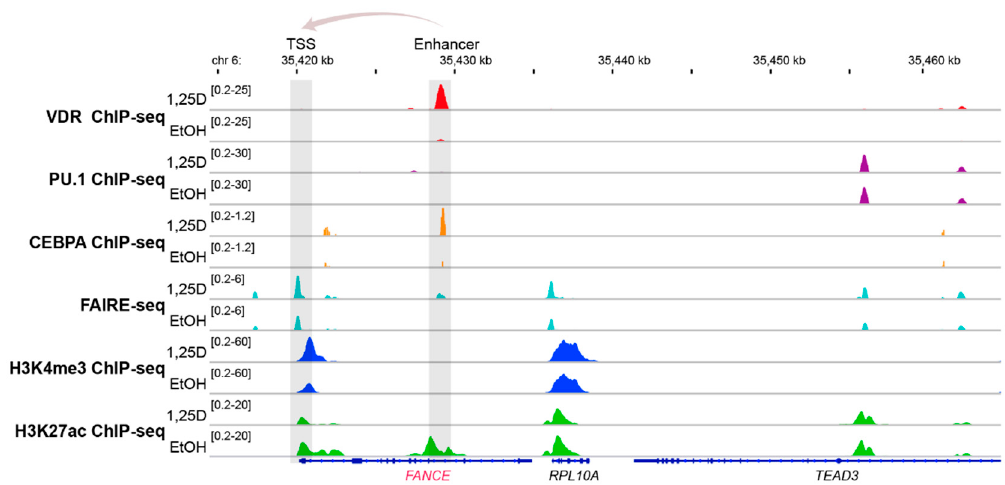
Figure 3. Vitamin D-triggered epigenomic profile in the region of the FANCE gene. The IGV browser [98] was used to display the epigenomic profiles at enhancer and transcription start site (TSS) regions of the vitamin D target gene FANCE . THP-1 cells had been treated for 24 h with 1,25(OH) 2 D 3 (1,25D) or vehicle (EtOH) and in three biological repeats, ChIP-seq experiments had been performed with antibodies against VDR [99], the pioneer factors PU.1 [100] and CEBPA [101], the histone marker for active transcription start site (TSS) regions, H3K4me3 [102] and the marker for active chromatin, H3K27ac [102], such as at enhancers, as well as FAIRE-seq [103] for accessible chromatin. The gene structures are shown in blue and vitamin D target gene FANCE is indicated in red. The genes RPL10A and TEAD3 serve as non-regulated references.